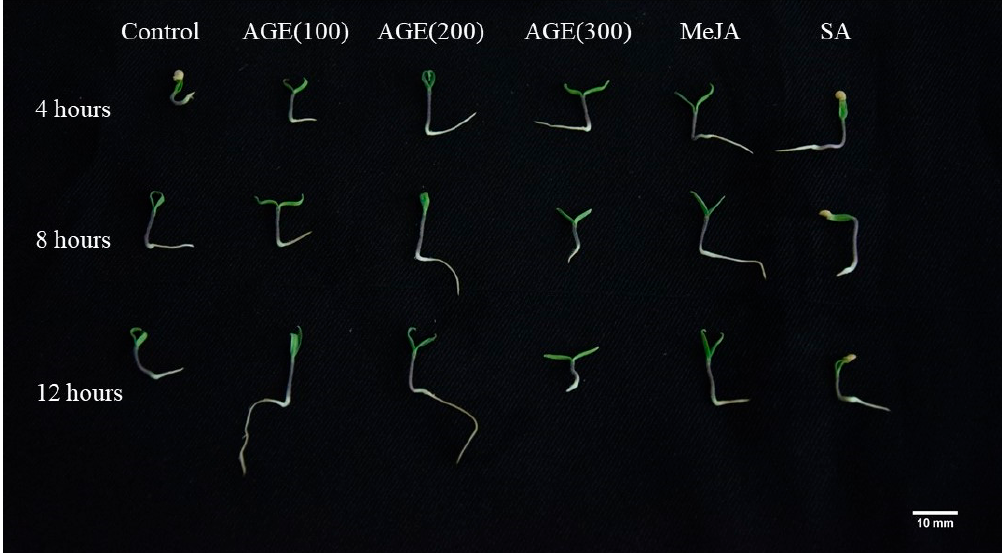
Figure 3. Seedlings growth after germination of the seeds primed with AGE, MeJA, SA, and distilled water. Control (distilled water), AGE (100, 200, and 300 µg mL − 1 ), MeJA (Methyl Jasmonate 0.05 mM), and SA (Salicylic acid 0.5 mM) whereas 4, 8-, and 12-h are the priming durations (Bar = 10 mm).